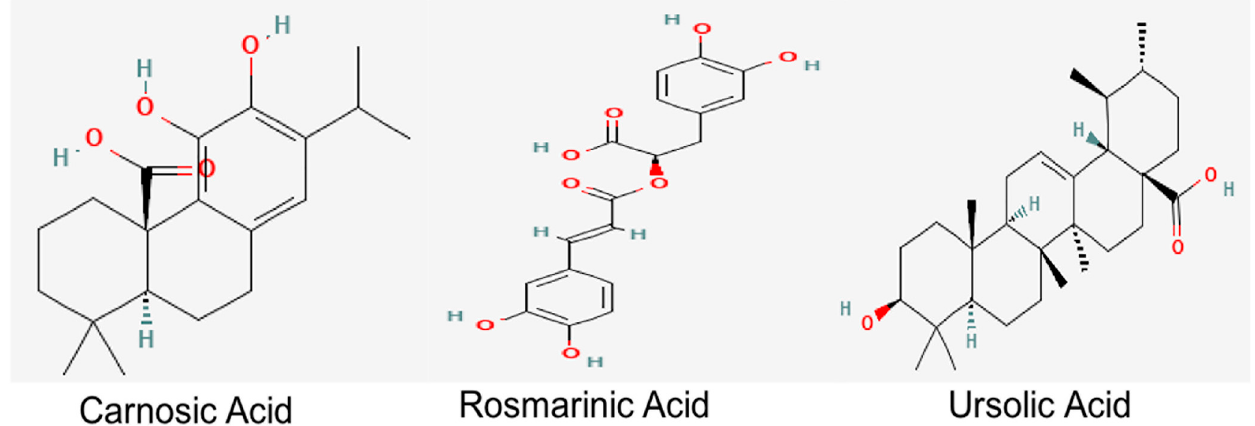
Figure 1. Chemical structures of bioactive constituents of R. officinalis. Structures were acquired from PubChem database.